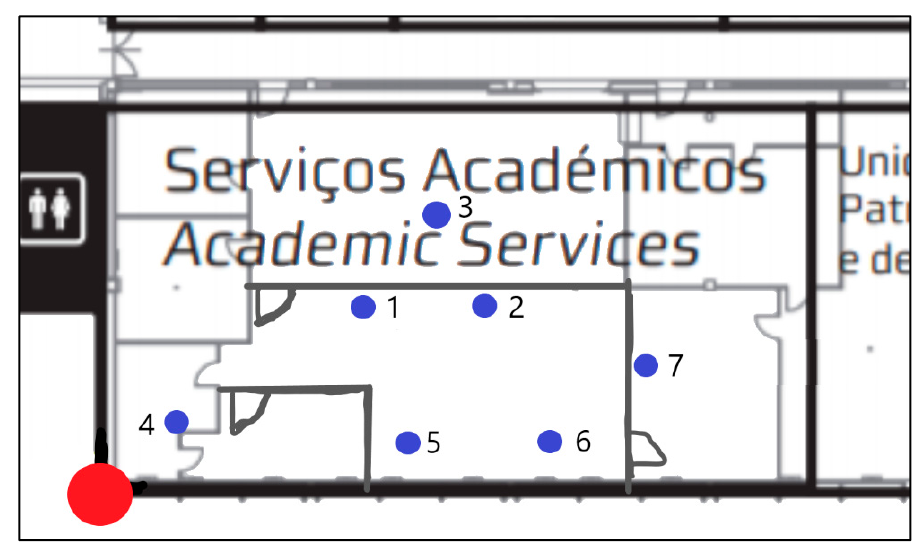
Figure 6. ISCTE-IUL University Academic Services, indoor sensors placement marked with blue circles and outdoor sensor marked with red circle.